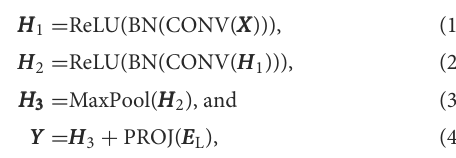
number of time windows and frequency bins, respectively, and the average BERT embeddings EEE L ∈ R L dim , the output, YYY ∈ R T out × F out ,